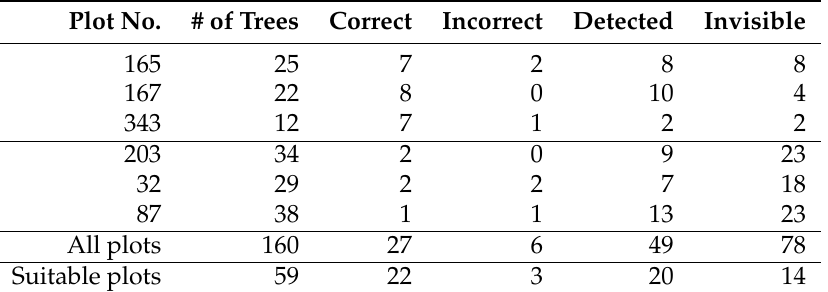
Table 2. Result at the plot level. Plots 165, 167 and 343 were sparse with mostly visible stems. Plots 203, 32 and 87 were dominated by spruce with many dry twigs and shrubs on the ground. Plot No.